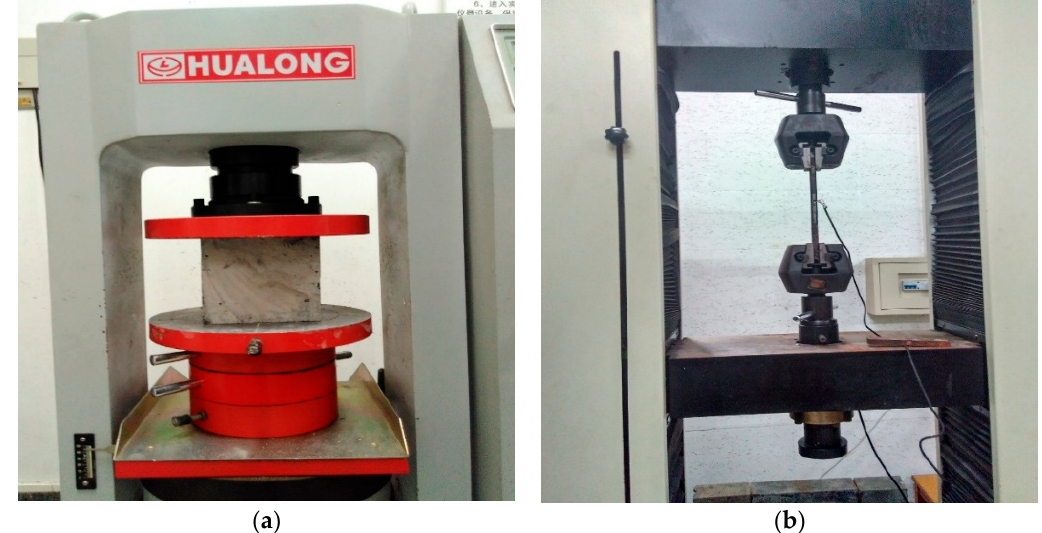
Figure 4. Mechanical property test of specimens. ( a ) Compressive strength test on concrete. ( b ) Tensile strength test on steel bars.